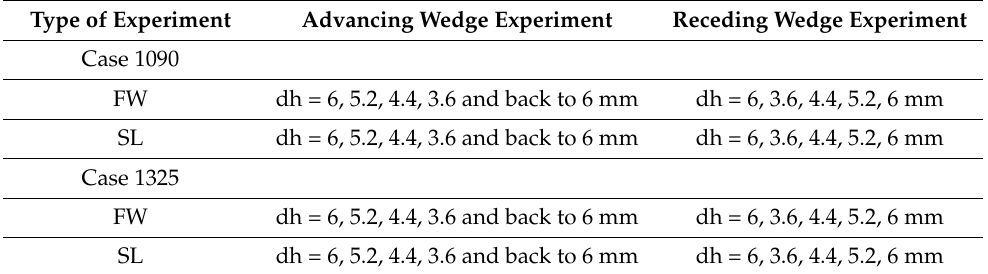
Table 1. Experimental cases investigated (dh refers to the head boundary